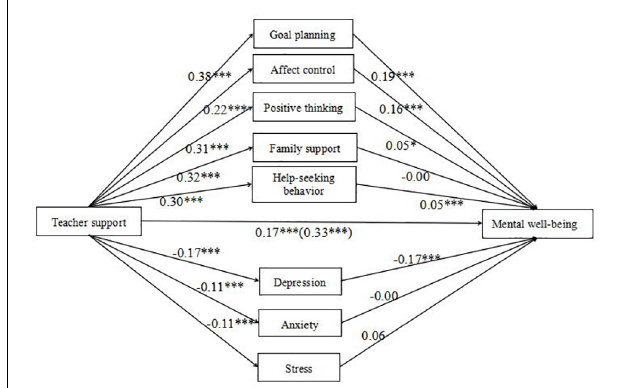
TABLE 3 | Direct, indirect, and total effects of teacher support on mental well-being in the parallel